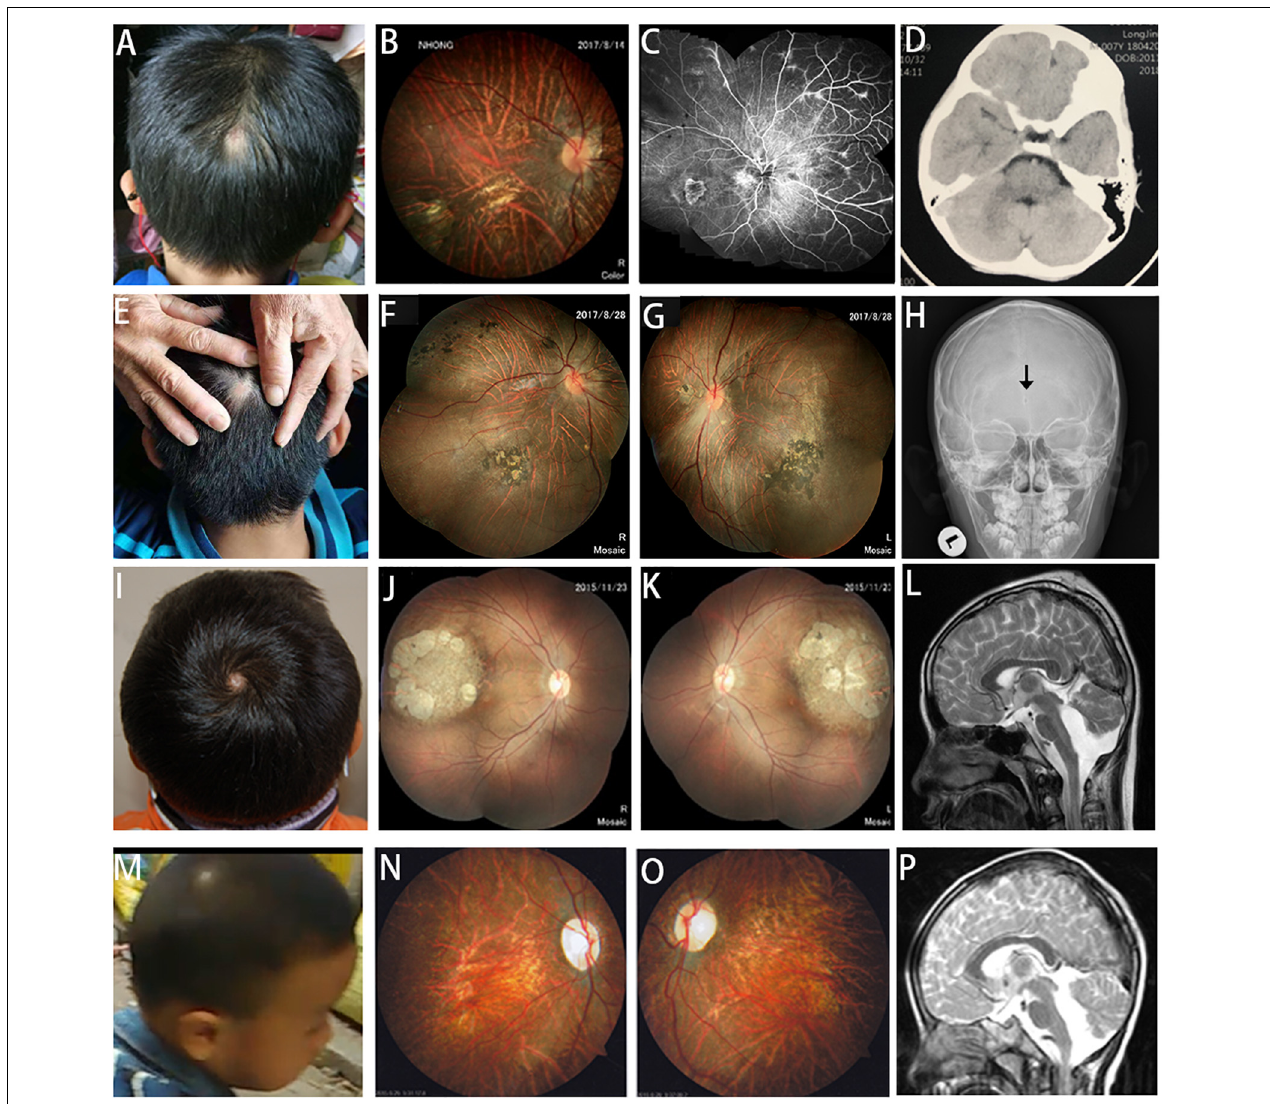
FIGURE 1 | Scalp defects, fundus changes, and neuroimaging in patients with COL18A1 and LAMA1 mutations. (A,E) Alopecia areata appears in the midline of the occipital region of patients with COL18A1 mutations. (I,M) Alopecia areata appears in the midline of the parietal region (in the center of hair whorl) in patients with LAMA1 mutations. (B,C,F,G,J,K,N,O) In addition to the typical high myopia fundus leopard-like pattern, dysplasia of the papilla, and macular degeneration, characteristic fundus degeneration can be observed for all patients including optic degeneration, chorioretinal sclerosis and atrophy, foveal hypoplasia, atrophic patch with extra bone spicule accumulation, and loss of pigmentation temporal to the macula. (C) Fluorescein angiograms reveal vascular leakage in patient 14410. (D) MRI reveals a normal brain image for patient 14410. (H) Black arrow indicates a small hole in the occipital region of patient 14518 by X-ray. (L,P)